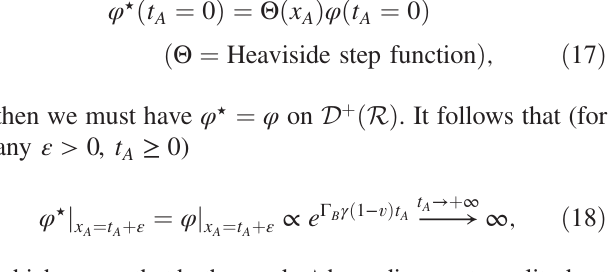
FIG. 4. Left panel: an observer inside the red region D þ ð R Þ cannot know what the initial state of the system was for x 0 ). Right panel: therefore, both φ ð t t A ¼ Θ ð x φ ð t 0 Þ are initial states which are consistent with the data A Þ A ¼ available to such observer; no experiment performed inside D þ ð R Þ can tell φ and φ ⋆